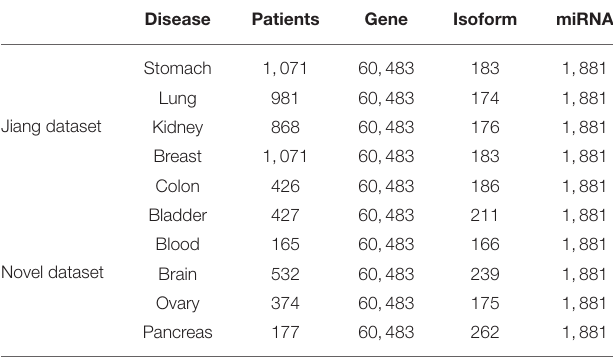
TABLE 1 | Description of Jiang dataset and Novel dataset from